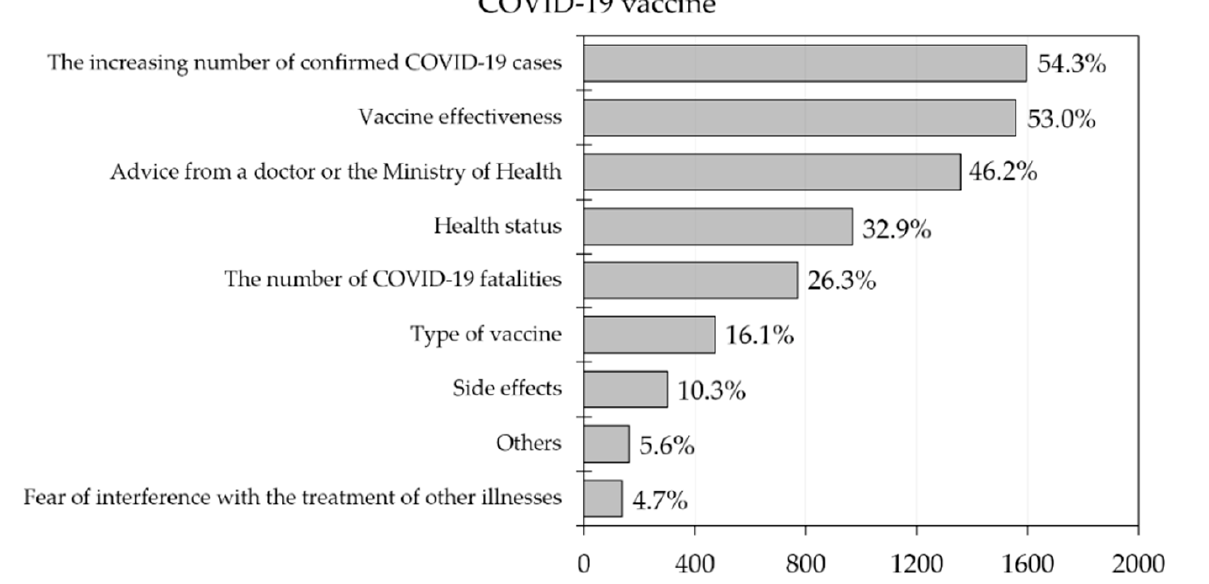
Figure 2. Factors that influenced the participants’ decisions to get a booster dose of COVID-19 vaccine ( n =